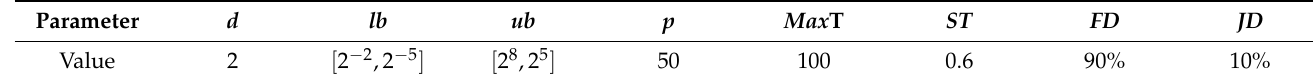
Table 2. The SSA-related parameters in SSA-SVM.